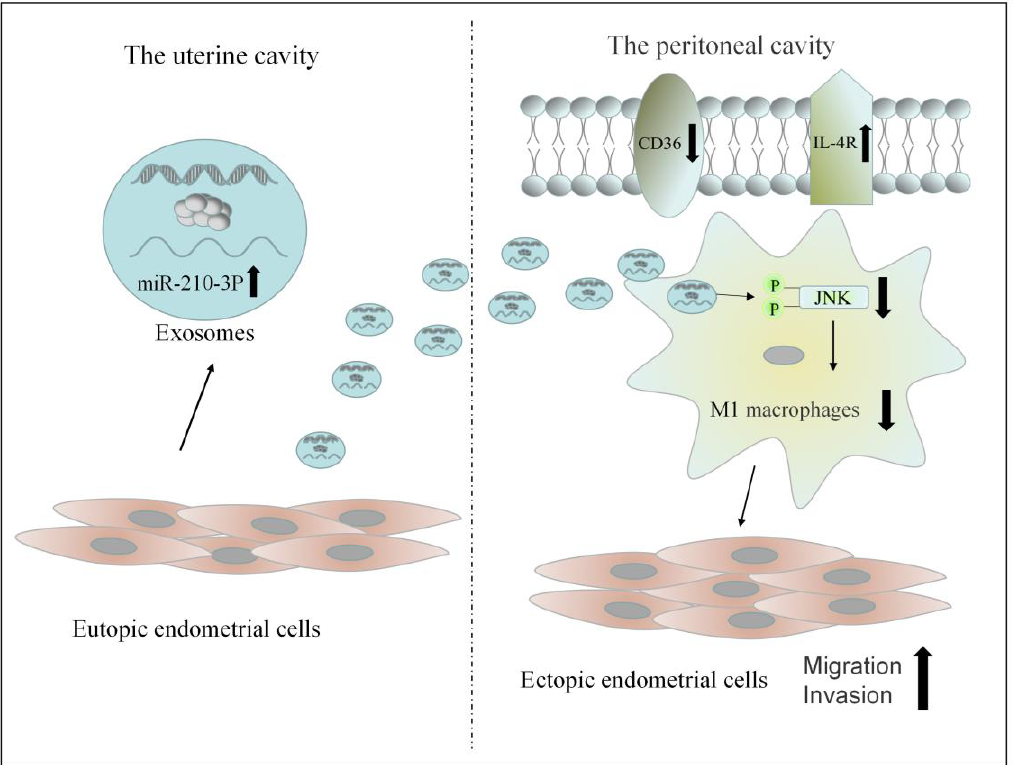
Figure 10. The possible mechanism of exosomes from the uterine aspirate fluid involved in the pathogenesis of endometriosis.